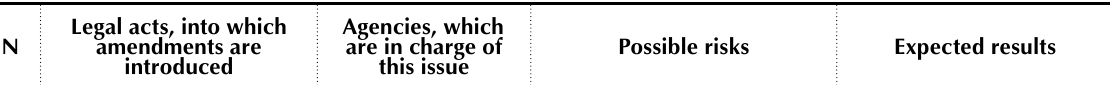
Table 4 (cont). Proposed measures of tax stimulation for subjects of the tourist market in the context of domestic